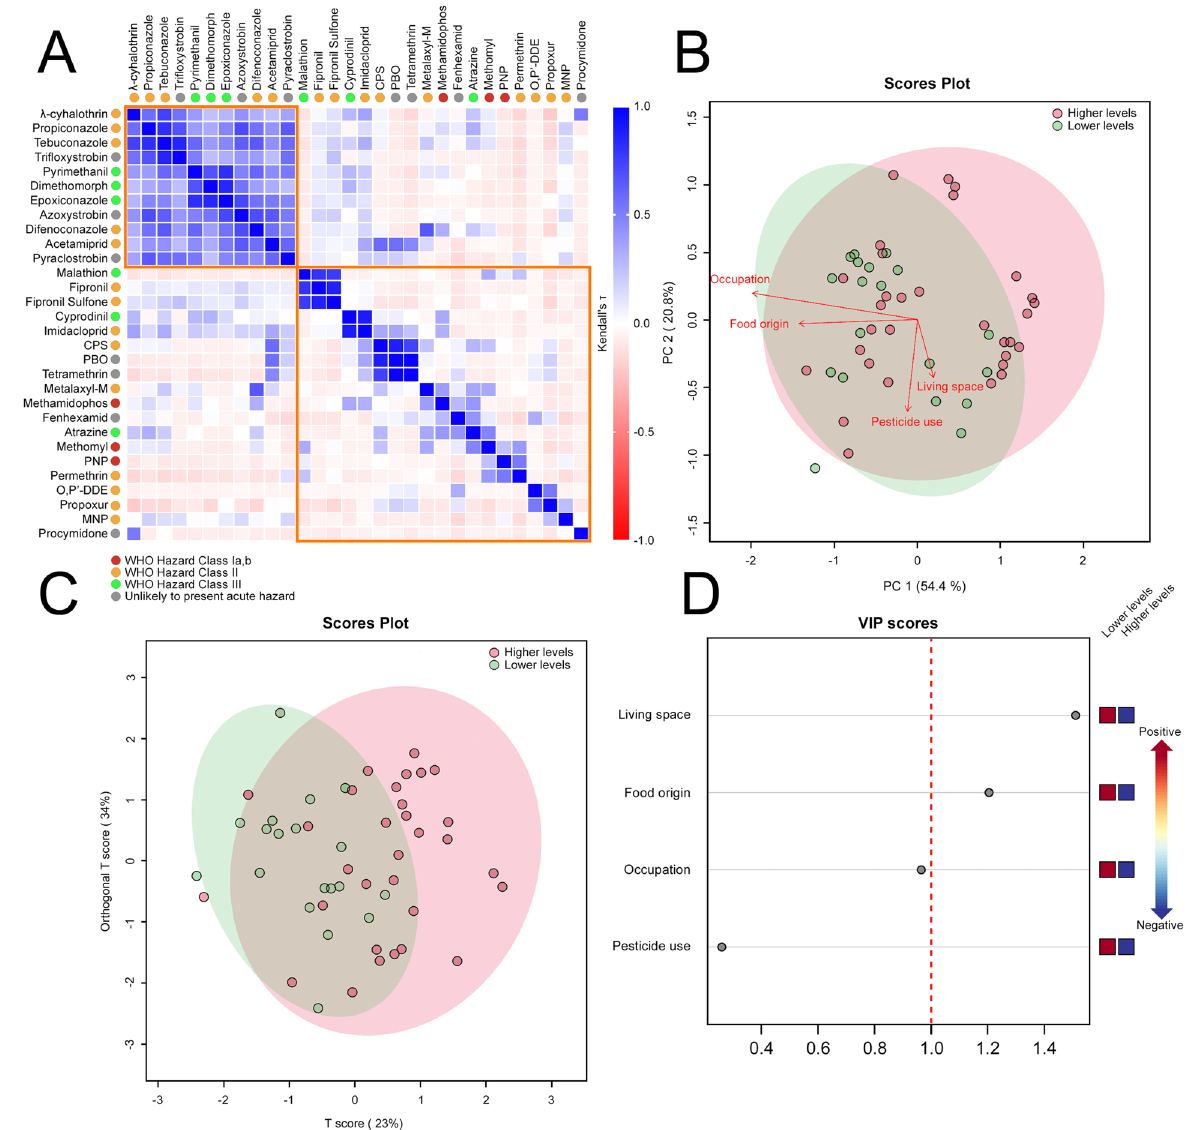
Colored areas represent 95% confidence regions. ( D ) Dot plot displaying VIP scores for each sociodemographic variable included in the OPLS-DA model. VIP score values: Living space, 1.51; Food origin, 1.20; Occupation, 0.96; Pesticide use, 0.26. The red dashed line indicates the cutoff threshold at VIP score = 1. Colored boxes on right indicate direction of association of the corresponding sociodemographic factor with high- and low- contaminated